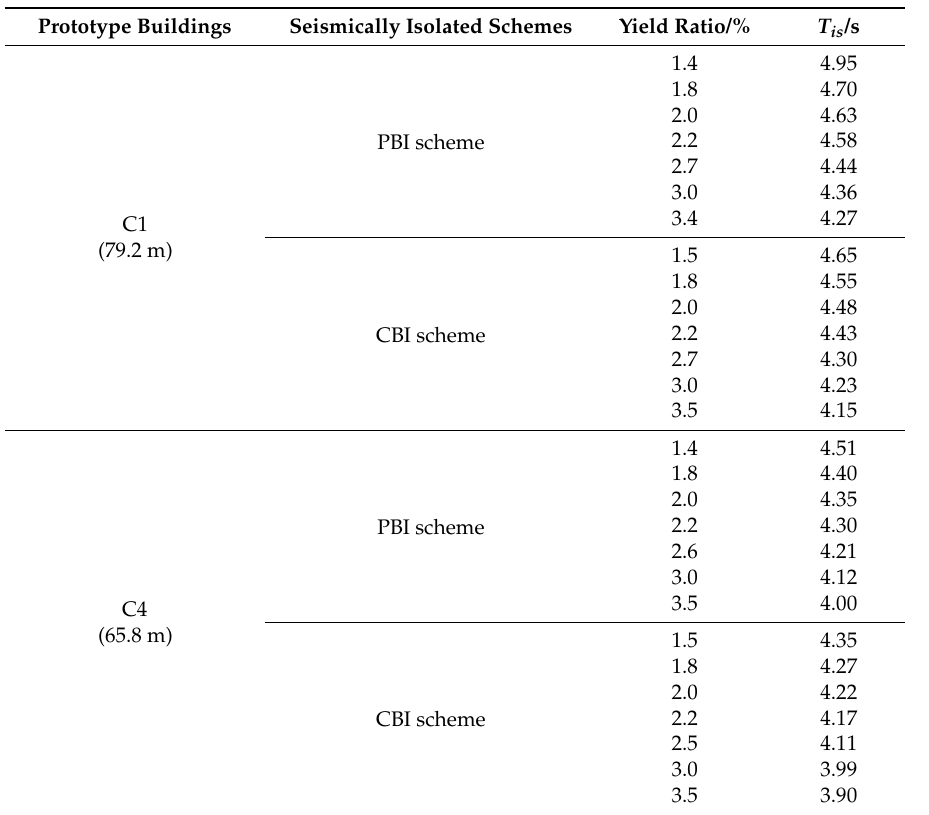
Table 3. Detailed information and corresponding T is of the study